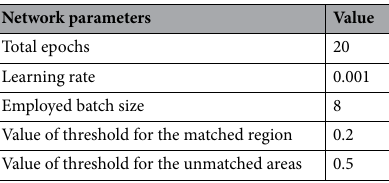
Table 2. Details of trainable parameters used by the introduced work.